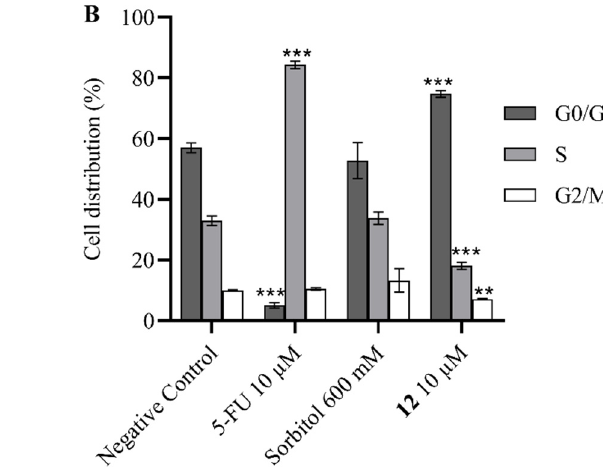
Figure 7. Analysis of apoptosis occurrence ( A ) and cell cycle distribution ( B ) of Caco-2 cells treated with the positive controls 5-FU (10 µM) and sorbitol (600 mM) and with the monomethine cyanine dye 12 (10 µM) after 72 h of incubation in the dark. Sorbitol was incubated for 24 h. The results are expressed as the average value ± standard deviation of two independent assays performed in duplicate. (**) p < 0.01 or (***) p < 0.001 versus the negative control.